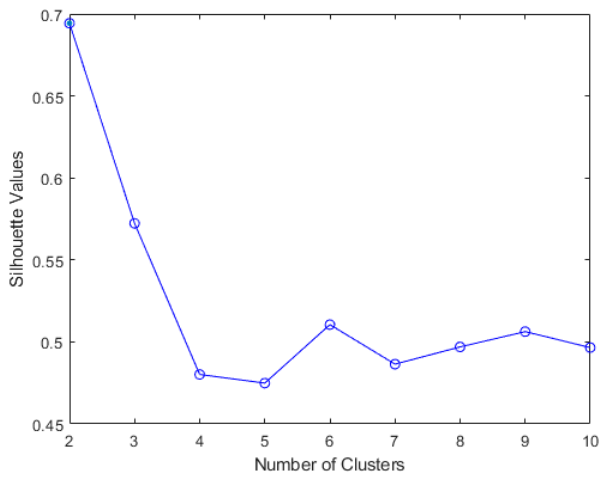
Figure 5. Elbow method results for Ward clustering algorithm (blue line indicates distortion score, and orange dashed line indicates the time to train the clustering model).